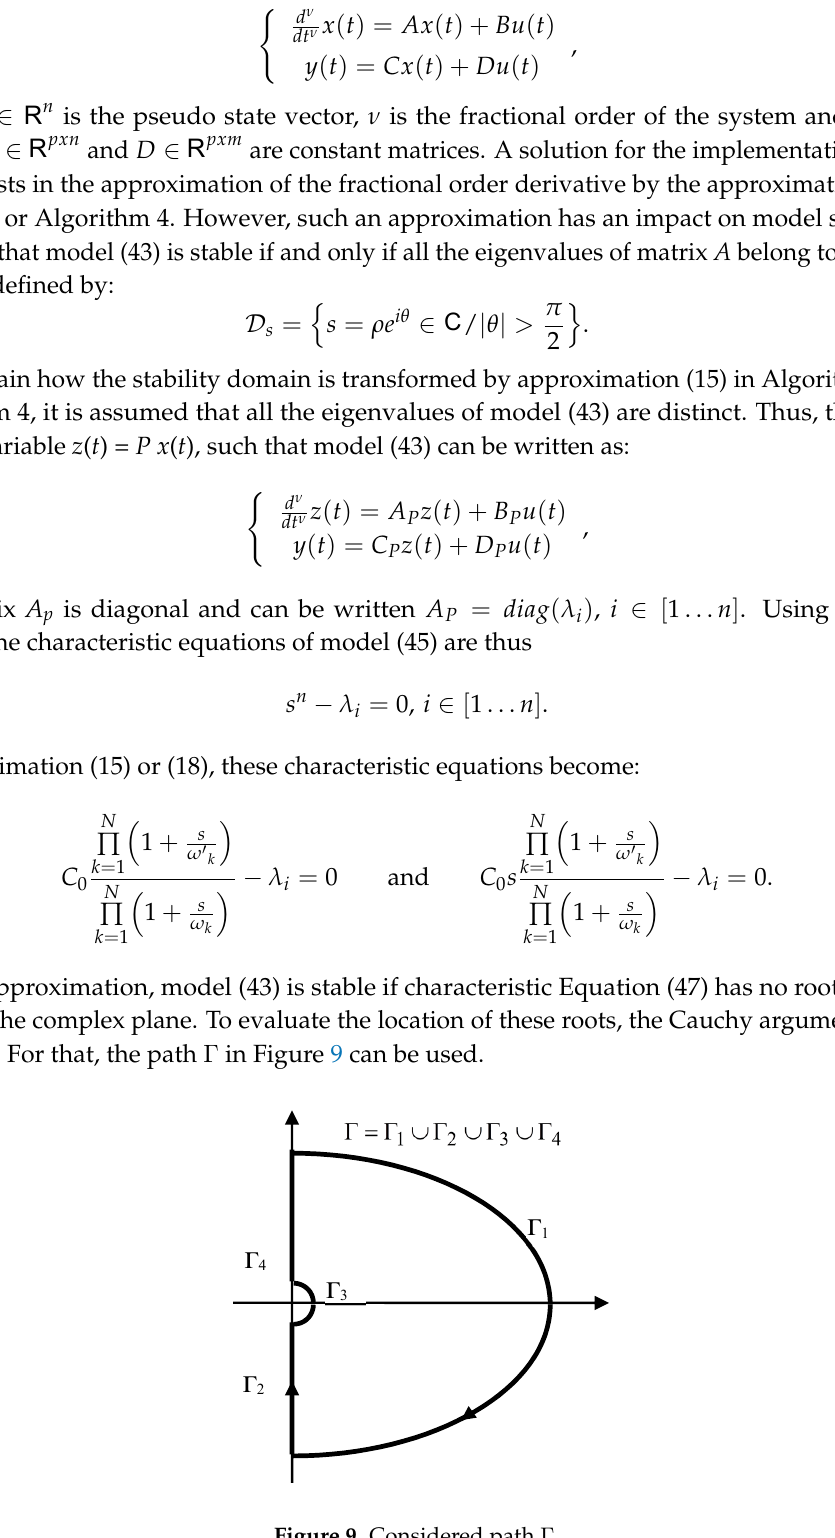
Figure 10. Image of path Г by approximations (15) and (18): definition of vector